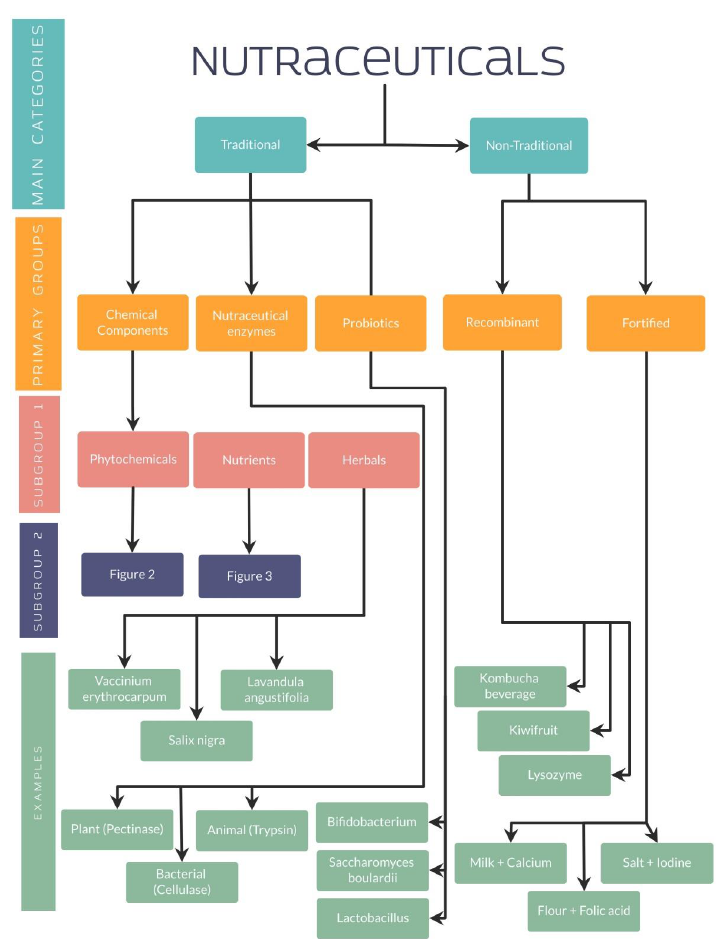
Figure 1. Nutraceutical classification.